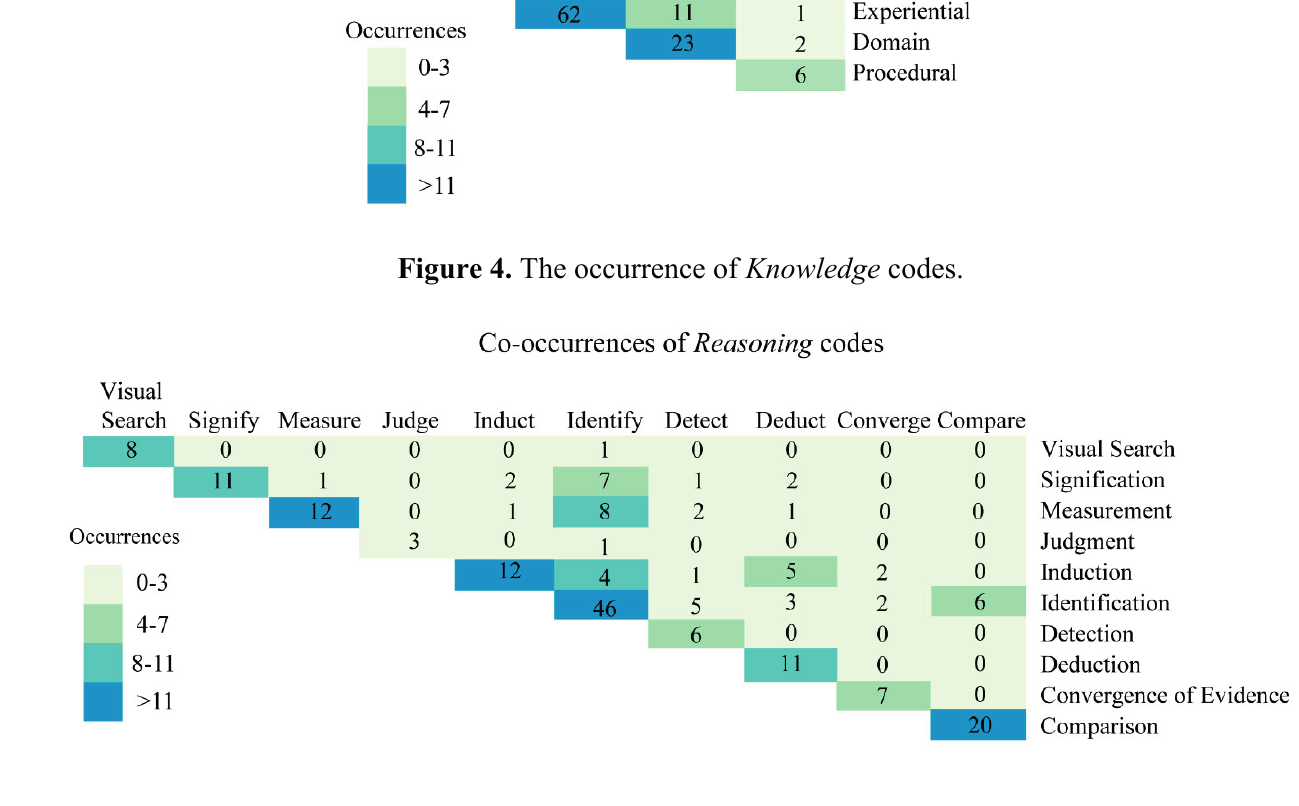
Figure 5. The occurrence of Reasoning Skills